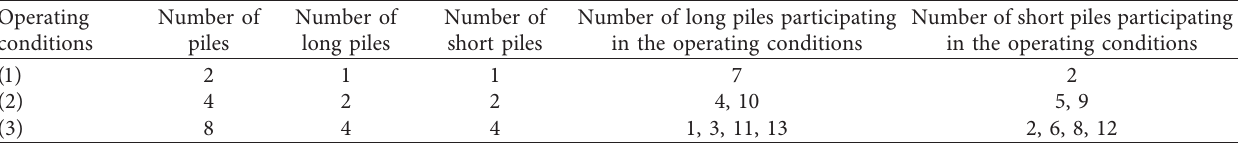
Table 1: Test schemes of composite pile foundations with long and short piles.